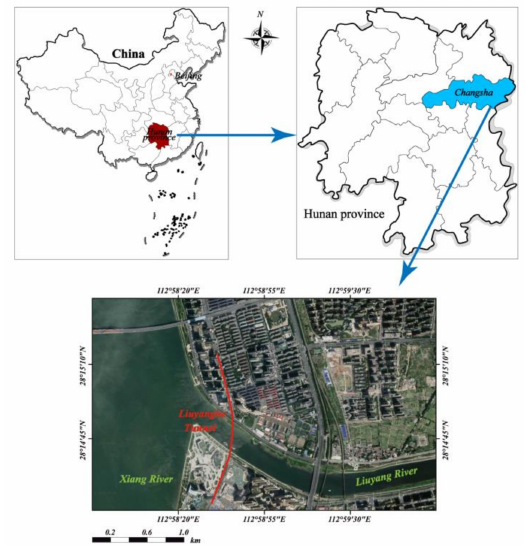
Figure 1. Topographic and geomorphological sketch of the study